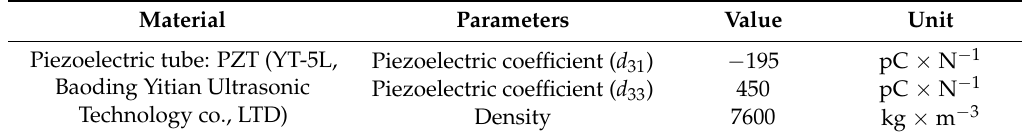
Table 1. Material parameters of the PA.